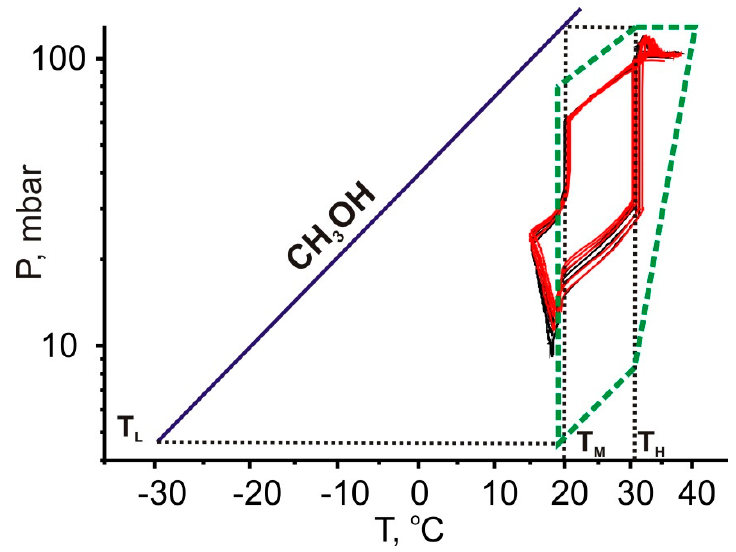
Figure 7. The ideal nonisothermal (dashed line) and experimental steady-state (solid lines) HeCol cycles with boundary temperatures of T L /T M /T H = –30/20/30 ℃ .